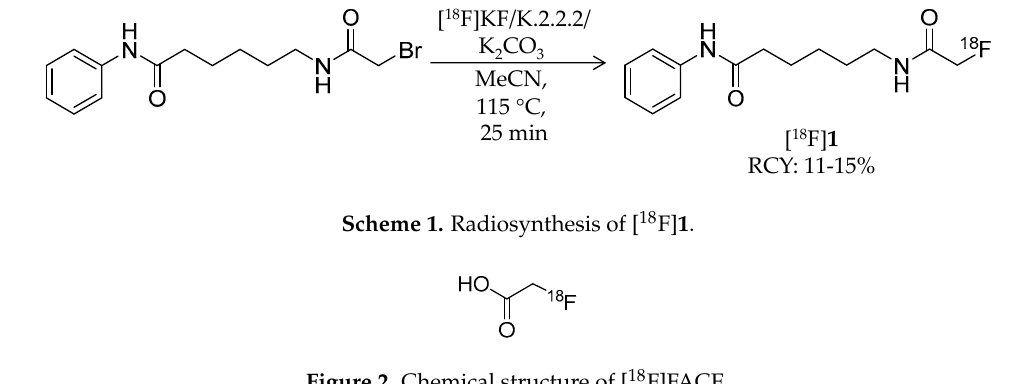
Figure 2. Chemical structure of [ 18 F]FACE.